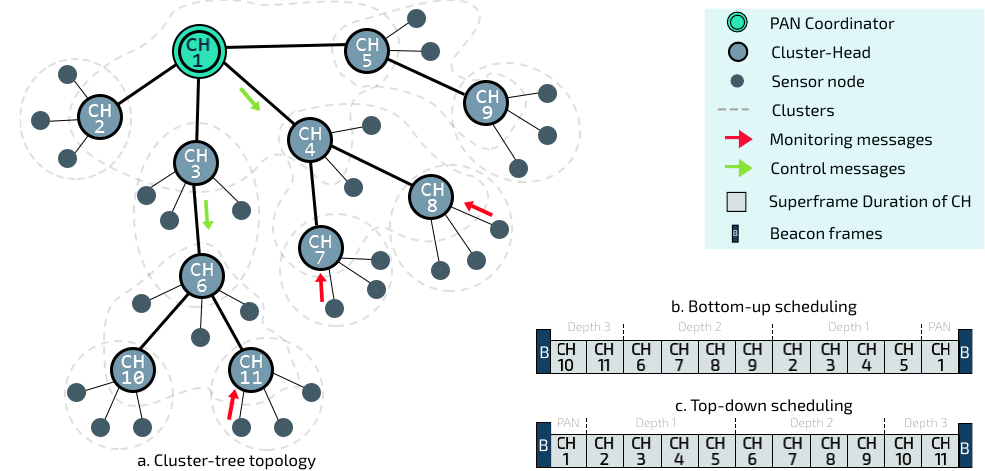
Figure 1. The cluster-tree WSN characteristics and the types of scheduling of its different traffic.